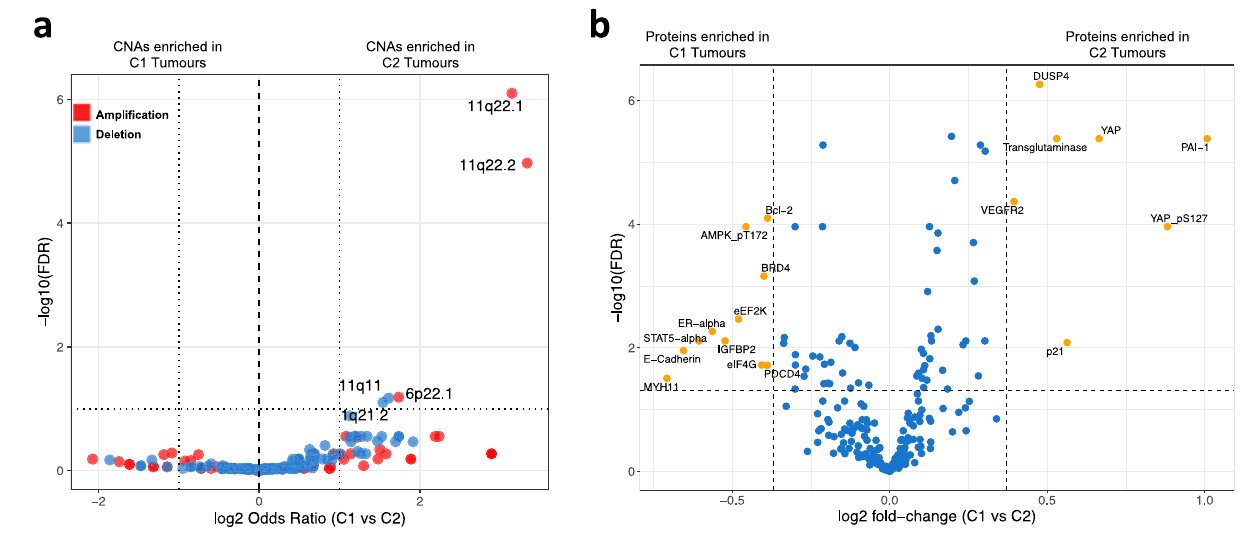
Fig. 5|Copynumberandprotein leveldifferencesbetweenSCCsubgroups.a 3 copynumberampli fi cations(redpoints)and2copynumberdeletions(bluepoints) were signi fi cantly enriched (Wald Test, FDR<0.05, horizontal dotted line) in C2 tumours as determined by binomial regression. GISTIC copy number peak fre- quencies betweenC1and C2tumours, alsohadto have alog2odds ratio (xaxis)>1 or < − 1 (verticaldottedlines) to be considered asenrichedineithercluster. b Using